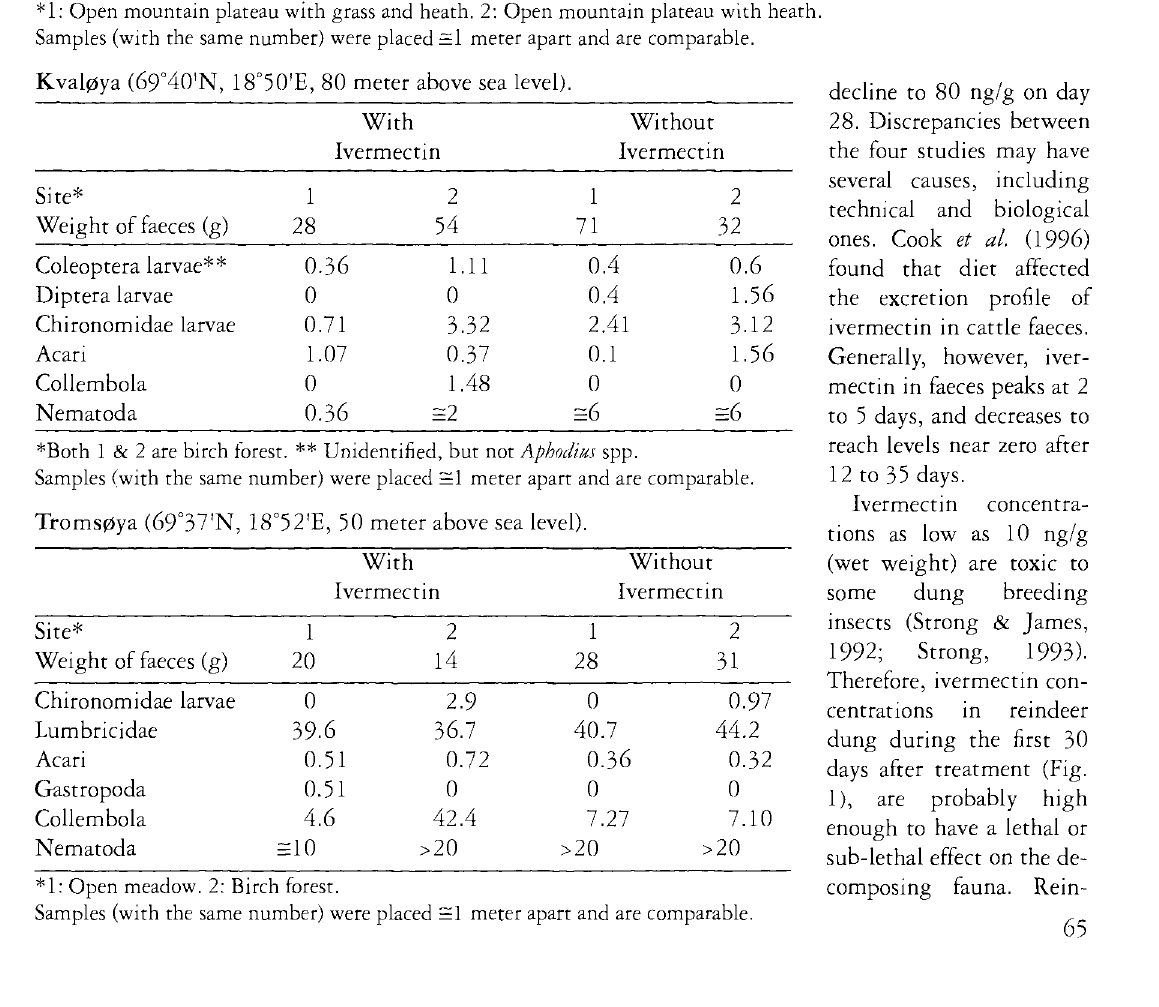
*1: Open mountain plateau with grass and heath. 2: Open mountain plateau with heath. Samples (with the same number) were placed =1 meter apart and are comparable.